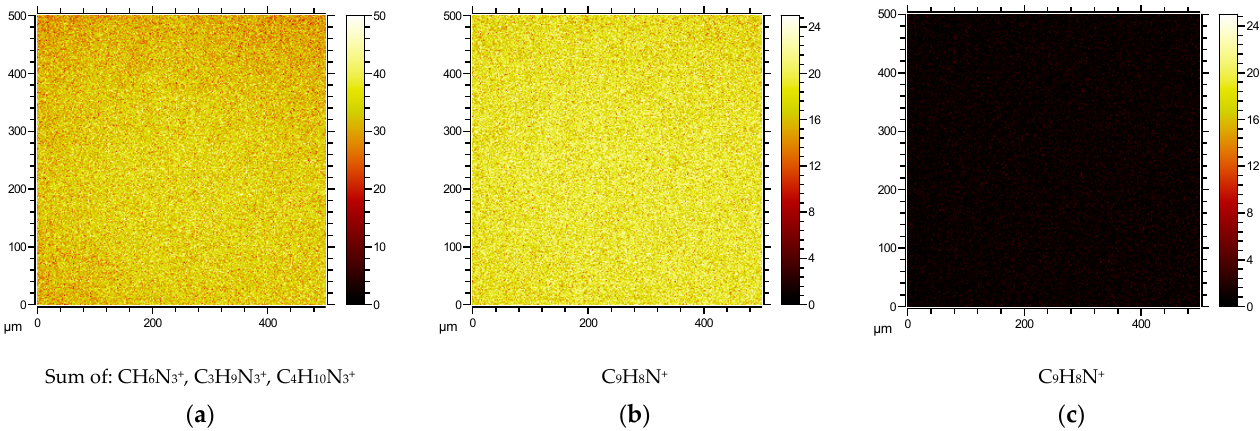
Figure 4. Typical ToF-SIMS images of an Au–SAM surface coated with azidopeptide-containing tryptophan, 1a : ( a ) ion intensities for CH 6 N 3+ , C 3 H 9 N 3+ , and C 4 H 10 N 3+ of arginine; ( b ) ion intensity of tryptophan indole-ion C 9 H 8 N + ; ( c ) ion intensity image of control Au–SAM surface observed at the tryptophan-specific ion C 9 H 8 N + .